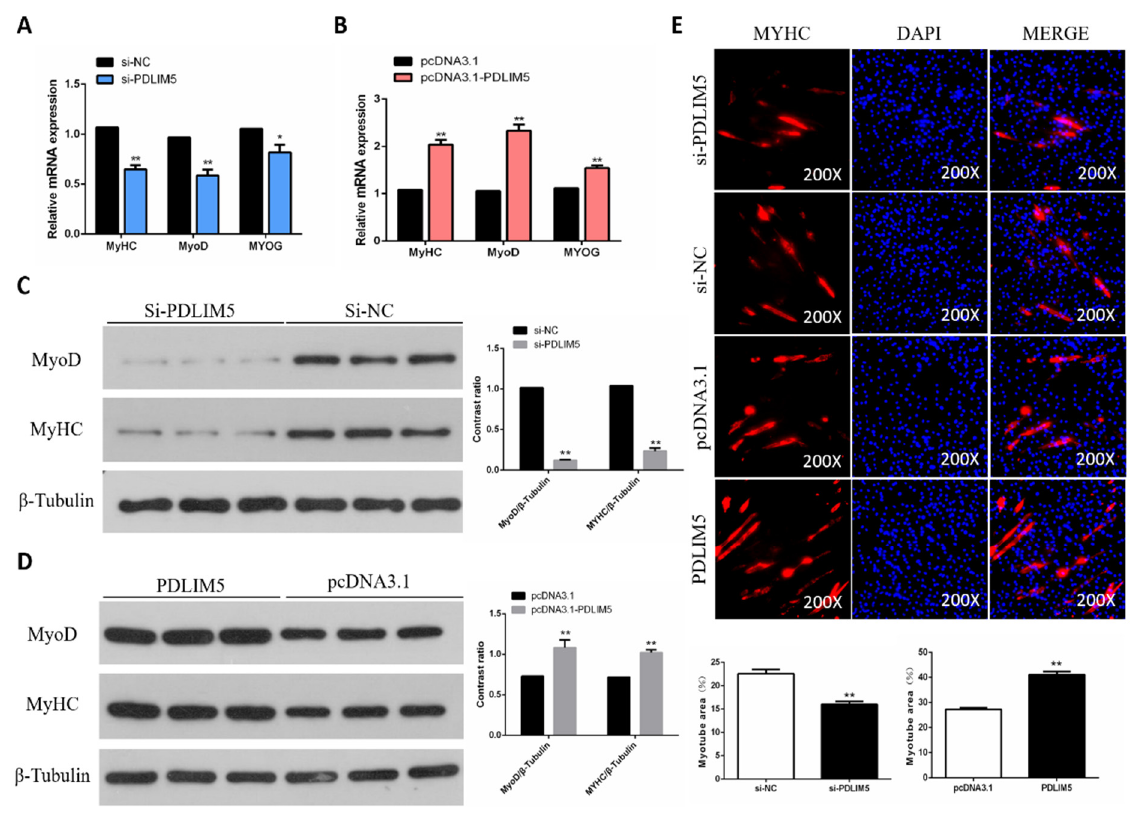
Figure 3. PDLIM5 increased chicken SMSCs differentiation. ( A , B ) Gene expression of myosin heavy chain (MyHC), myogenic differentiation 1 (MyoD), and myogenin (MyoG) in SMSCs after overexpression or knockdown of PDLIM5. ( C , D ) Protein abundance of MyHC and MyoD in SMSCs after overexpression or knockdown of PDLIM5. ( E ) The immunofluorescence pictures and myotube area statistics of SMSCs after overexpression or knockdown of PDLIM5. In the picture, red represents myosin and blue represents stained nuclei. * p < 0.05; ** p < 0.01 vs. NC and pcDNA3.1 (negative control) ( n = 9).